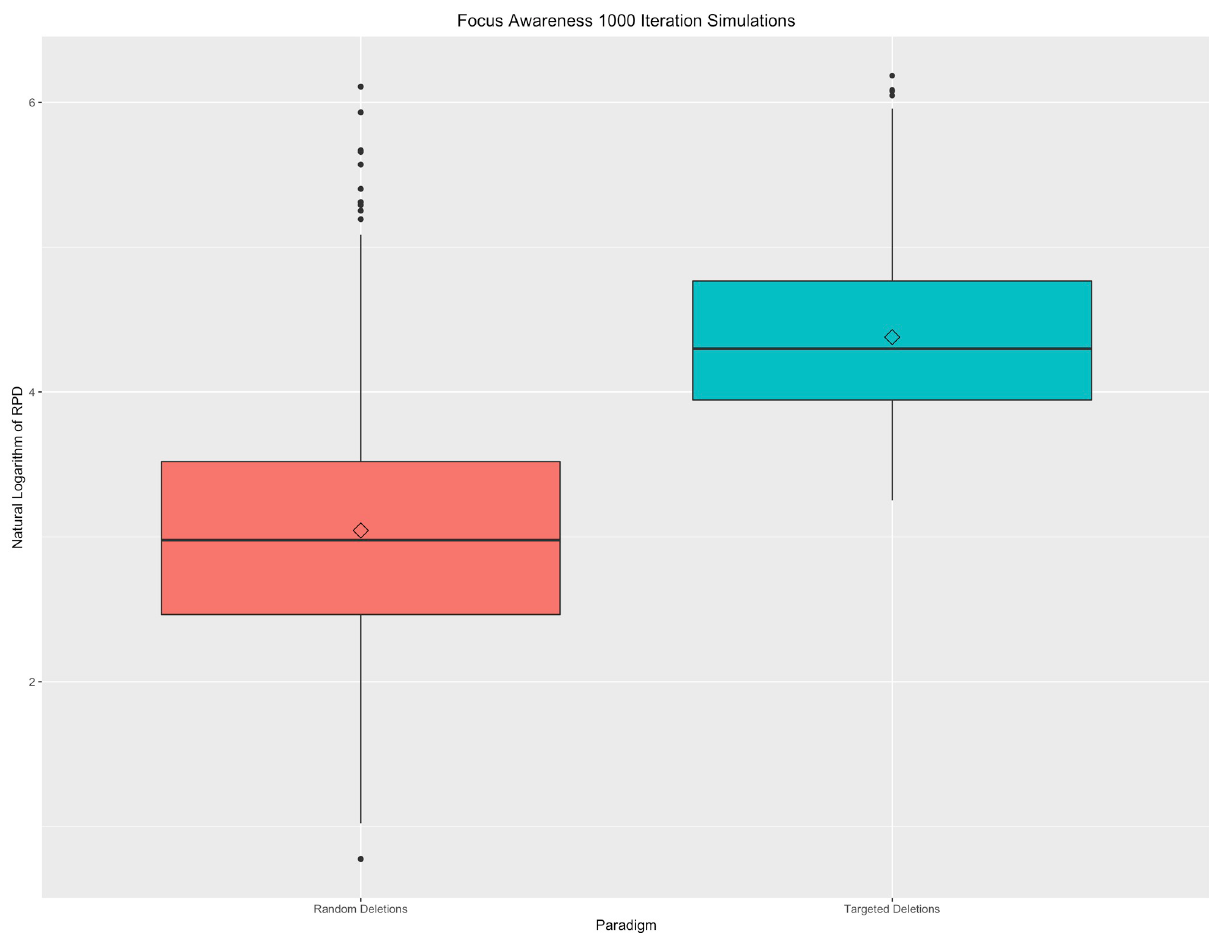
Fig 5. Focus awareness property. Boxplot of 1000 iterations under targeted and random change paradigms. A natural logarithm transformation has been applied to all resistance perturbation distance values for this figure. Targeted deletions, on average, results in larger RPDs than in comparable random graph